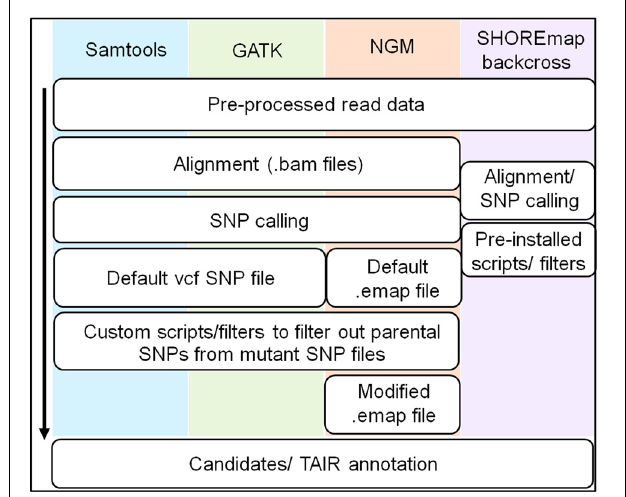
FIGURE 3 | NGM outputs for chromosomes I and III plotted against genome position. Parental SNP filtered .emap files were interrogated via the NGM web portal, with the Ch D threshold set at zero, and all SNPs identified are shown as red dots for chromosomes I and III. The blue dashed line indicates the default Ch D threshold of 0.85 used to identify the six SNPs indicated in Table 1 . The black arrow indicates the SNP identified in HASTY .